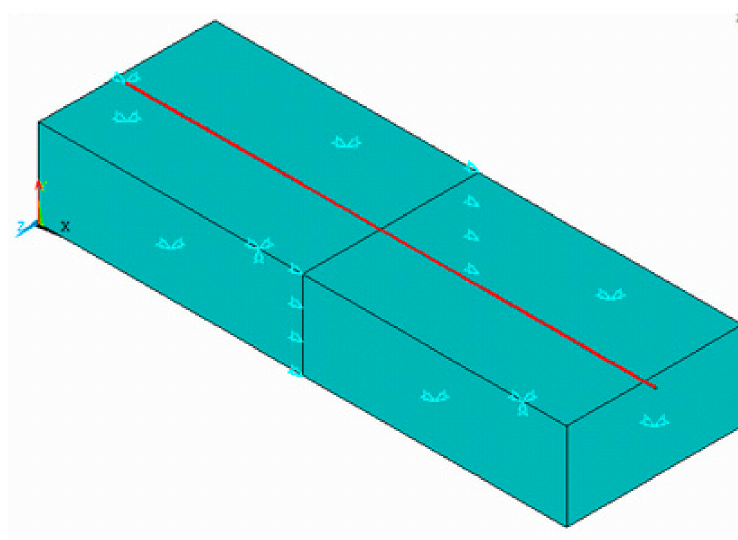
Figure 5. Finite element analysis diagram of buried pipeline.